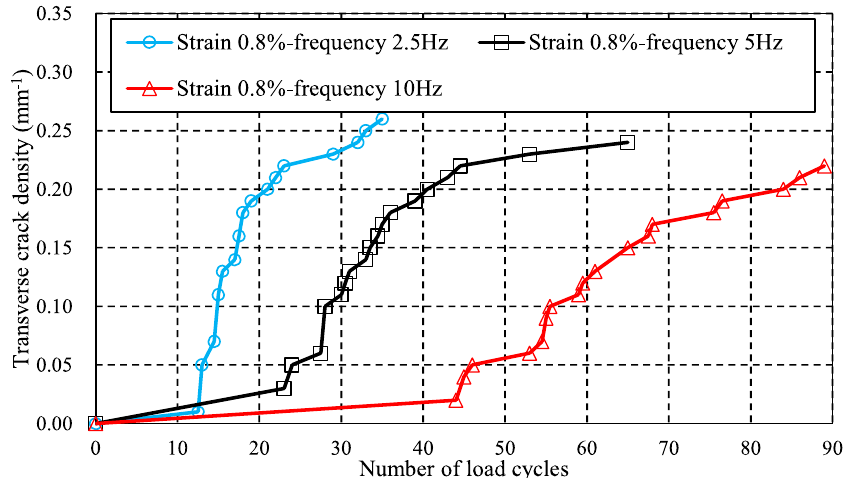
Figure 13. Effect of stress level on transverse crack density: strain boundary condition varies from 0.6% to 0.8% while the load frequency is fixed at 5 Hz.